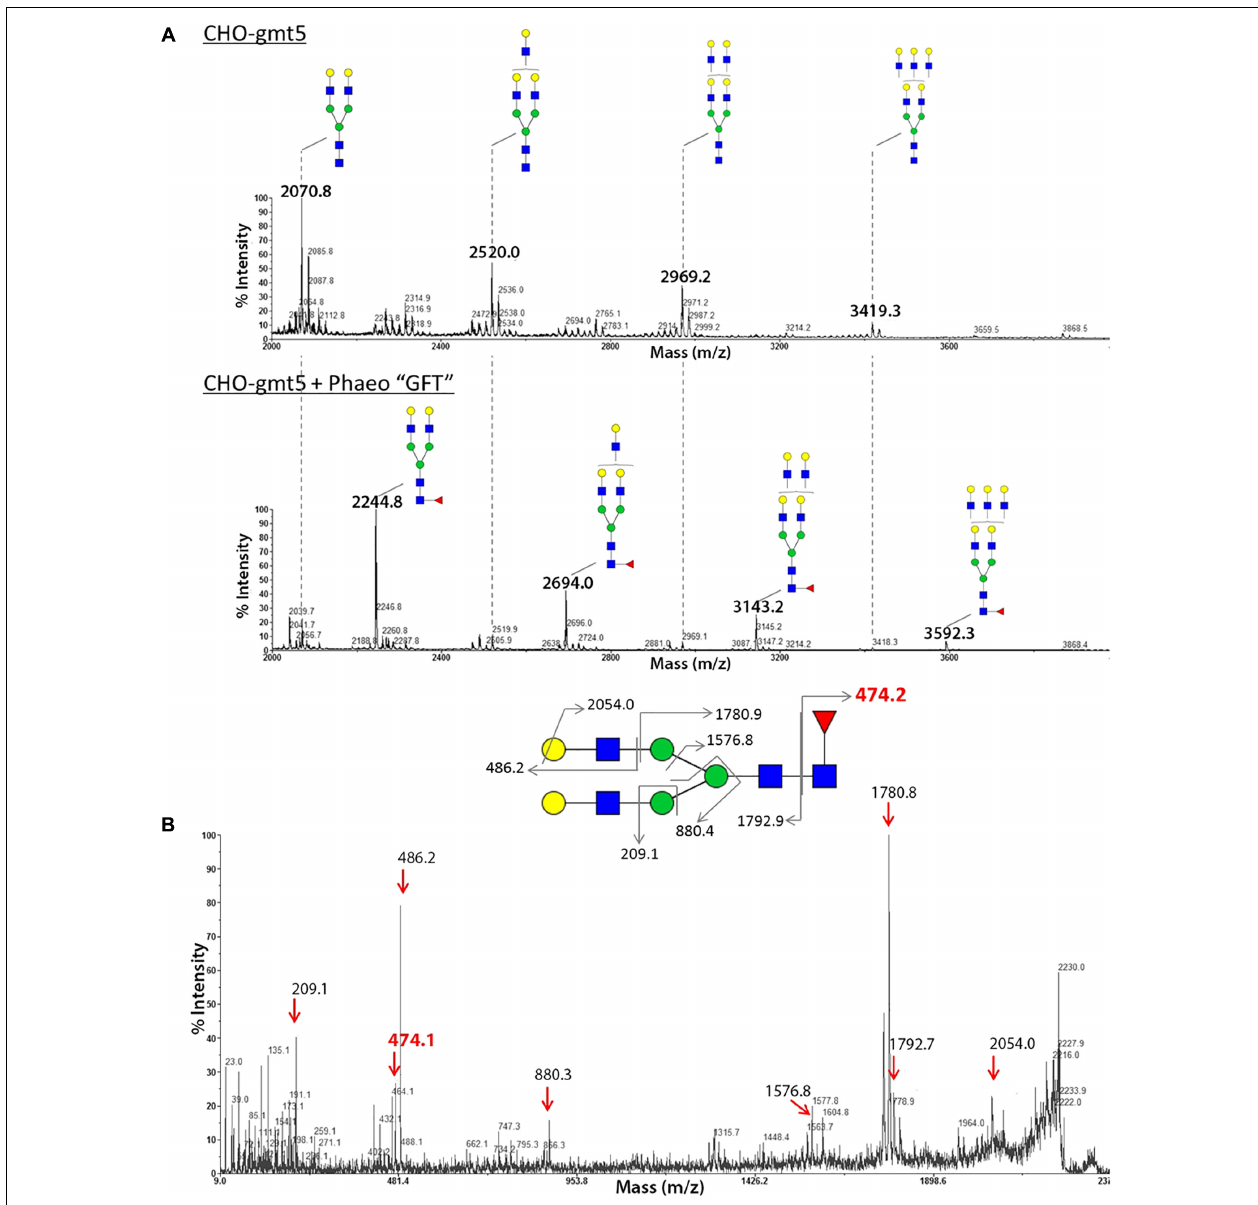
FIGURE 4 | Analysis of the N -glycan profile of proteins from CHO gmt5 cells expressing PtGFT revealed fucosylated N -glycans. MALDI-TOF MS profiles of permethylated N -glycans isolated from total proteins of (A) CHO-gmt5 cell line before (CHO-gmt5) or after complementation with the PtGFT (CHO-gmt5 + Phaeo“GFT”). (B) MS 2 fragmentation pattern of a biantennary N -glycan at m/z 2244 demonstrating that the fucose residue is linked to the proximal GlcNAc residue. (cid:4) N-acetylglucosamine, • galactose, • mannose, (cid:72)